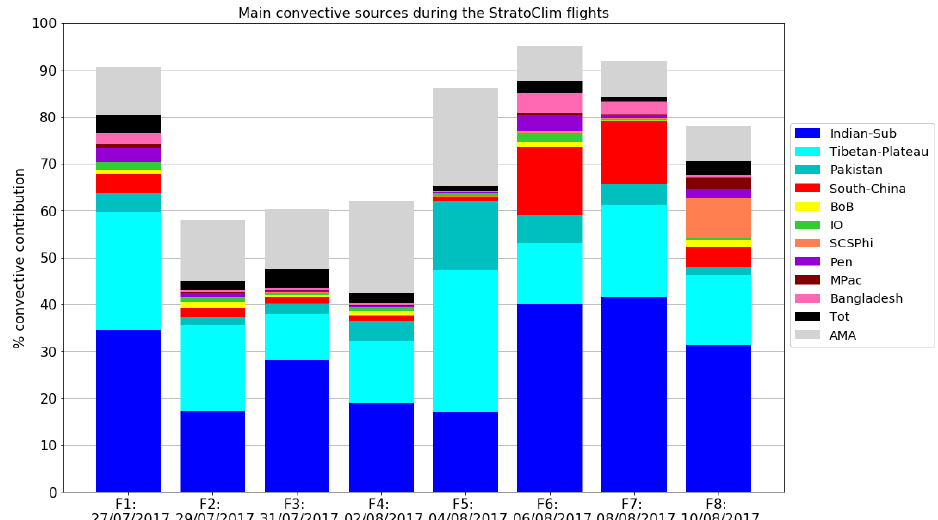
Figure 11. (a) Vertical distribution of convective influence as individuated from the trajectories through the whole campaign. Colours indicate the different regions as in Fig. 3, and the numbers indicate the mean age of transport for each source region at that height bin. (b) Mean CO concentration (black) and the 5th (dark grey) and 95th percentiles (light grey) for the different height bins, as seen by the COLD2 instrument through the whole